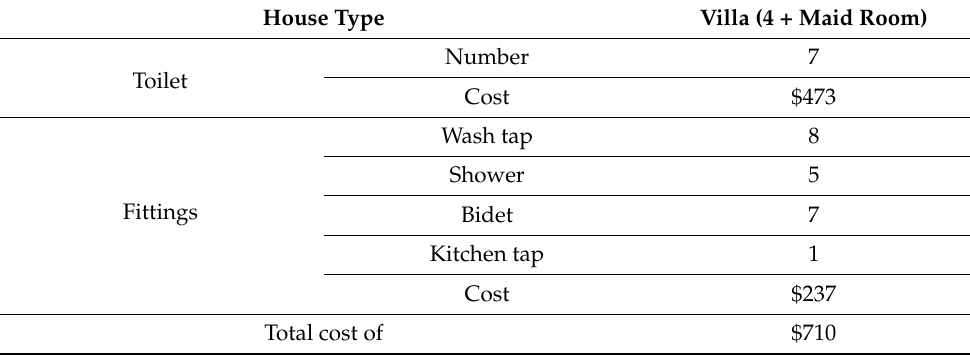
Table 4. Water-saving fitting and dual-flush toilet cost for a national